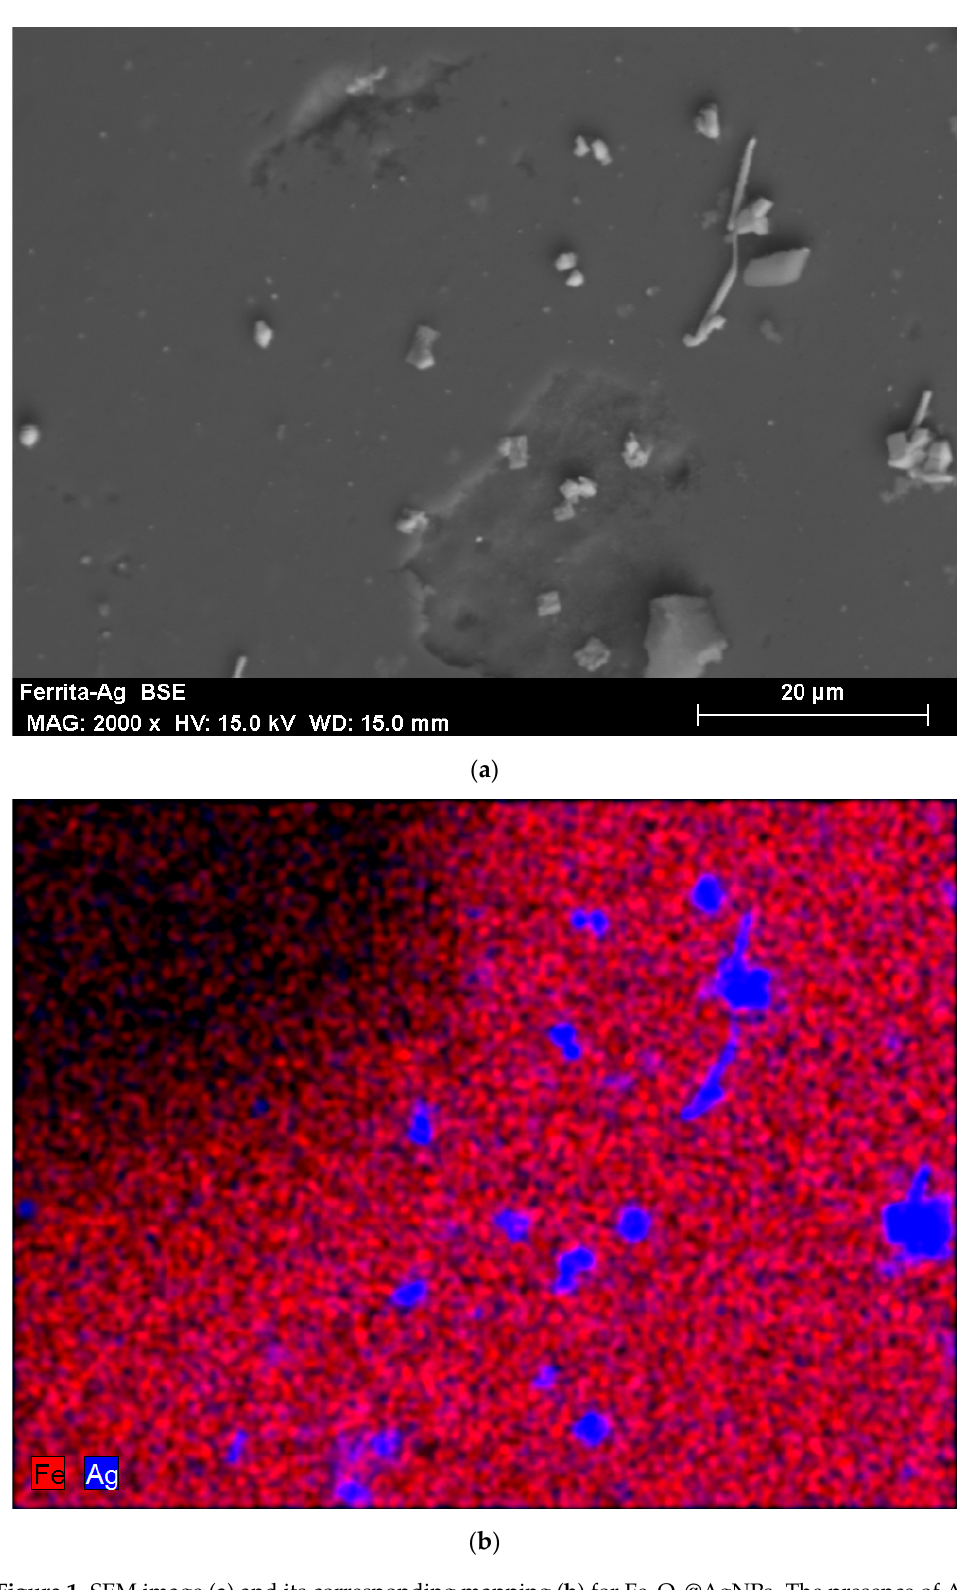
Figure 1. SEM image ( a ) and its corresponding mapping ( b ) for Fe 3 O 4 @AgNPs. The presence of Ag in the sample is revealed through the lighter structures ( a ) and the highlight in blue color ( b ). To confirm the presence of Ag in the adsorbent, Figure 2 shows the energy dispersive X-ray spectroscopy (EDX) pattern for Fe 3 O 4 @AgNPs associated to the SEM, where the